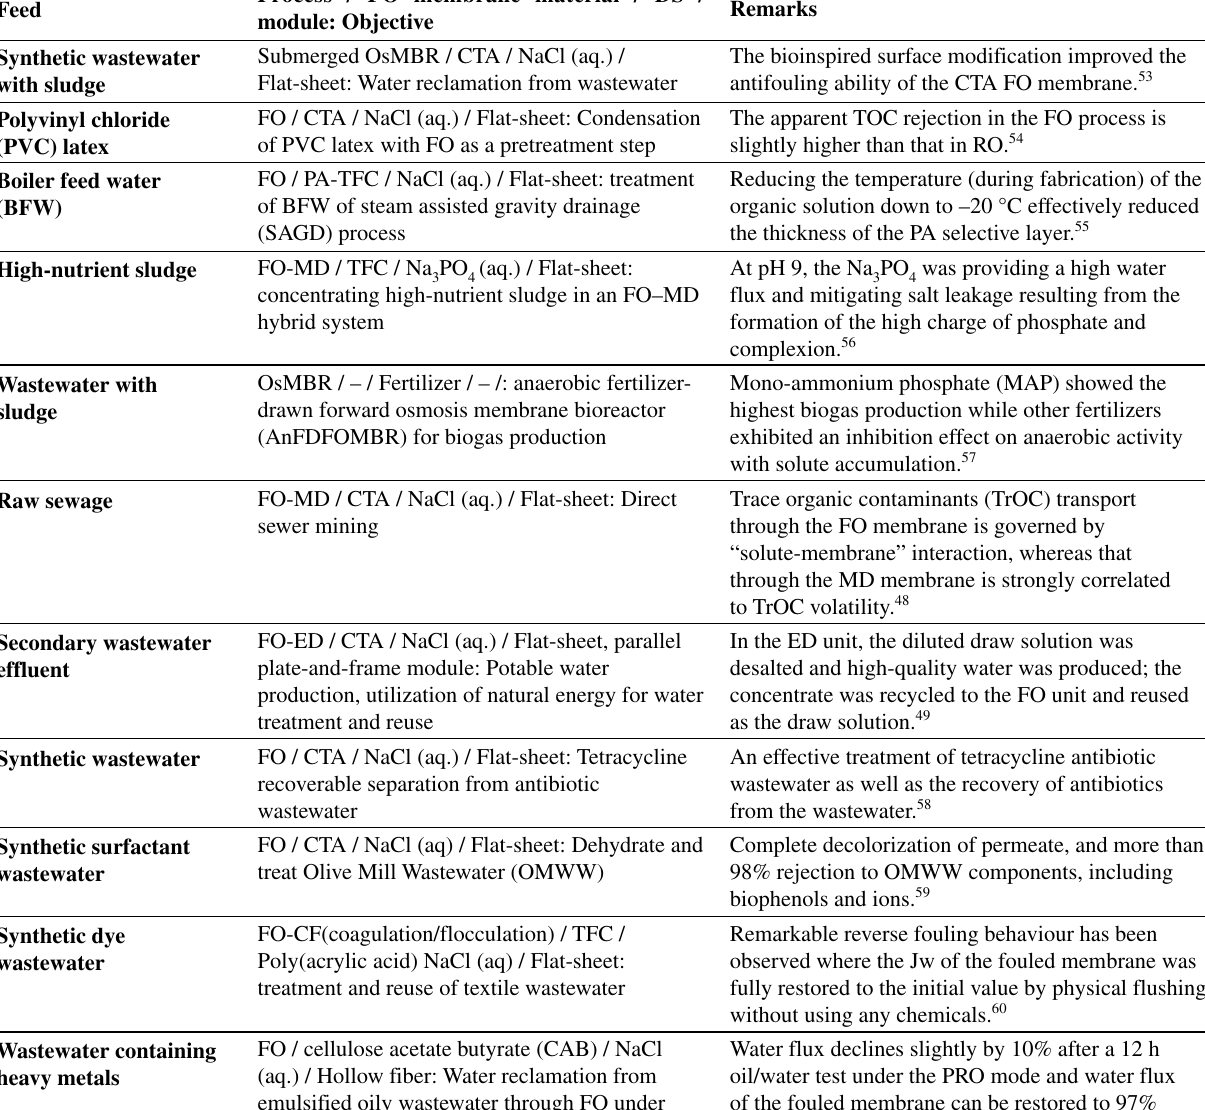
Table 2. An overview of various FO application in last five